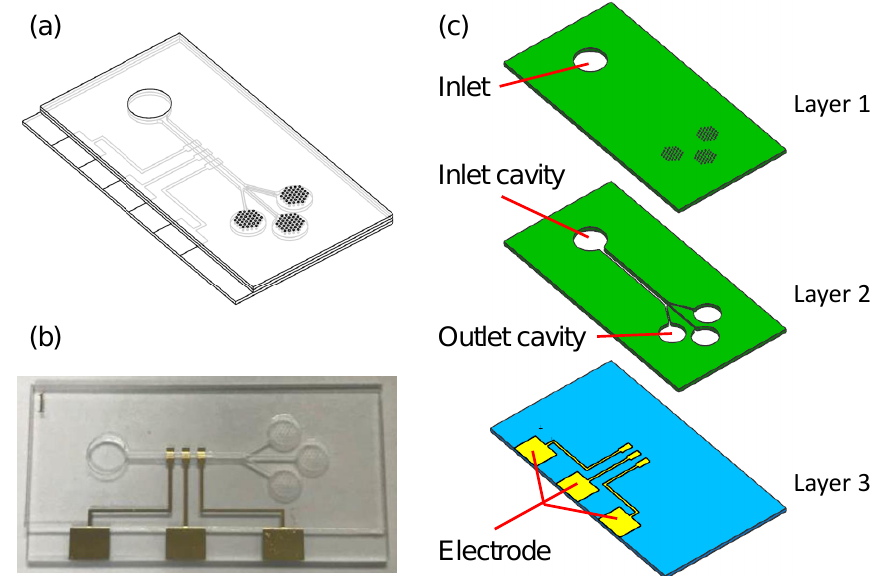
Figure 1. ( a ) Schematic of the proposed microfluidic device; ( b ) an image of the real device; and ( c ) structural diagram of the device consisting of three